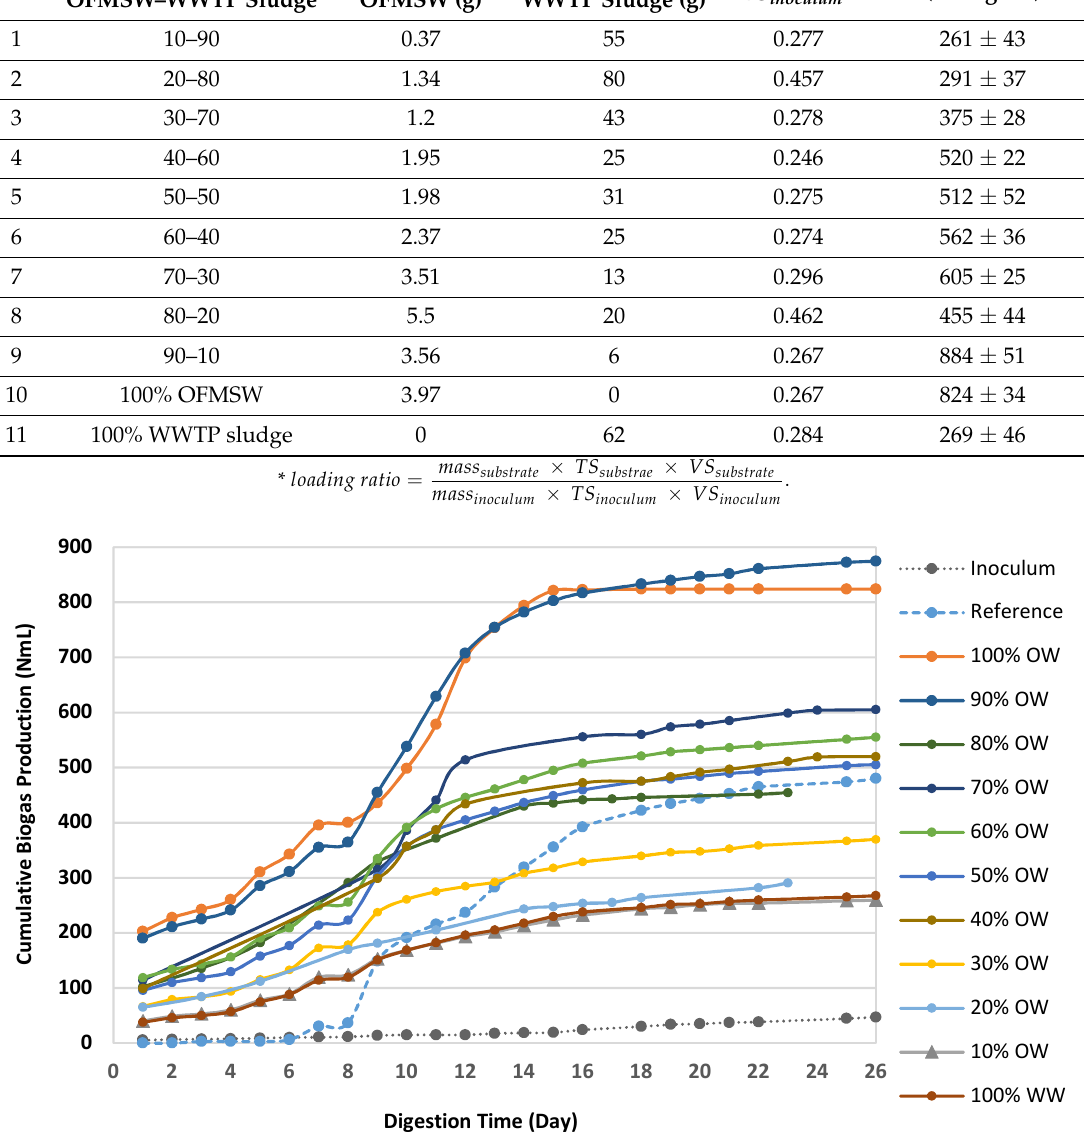
Total Production Table 4. The biogas production at different mixing ratios attained from the climate room system. * VS inoculum Total Production 𝒔𝒖𝒃𝒔𝒕𝒓𝒂𝒕𝒆 * 𝑽𝑺 𝒊𝒏𝒐𝒄𝒖𝒍𝒖𝒎 (Nml/g VS) OFMSW–WWTP Sludge